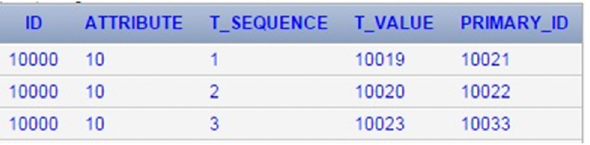
Figure 12. New virtual data table.